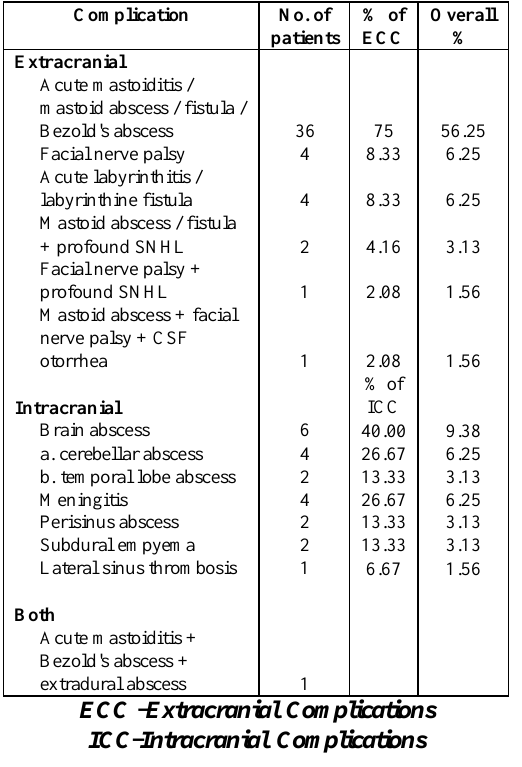
Table II. Distribution of complications